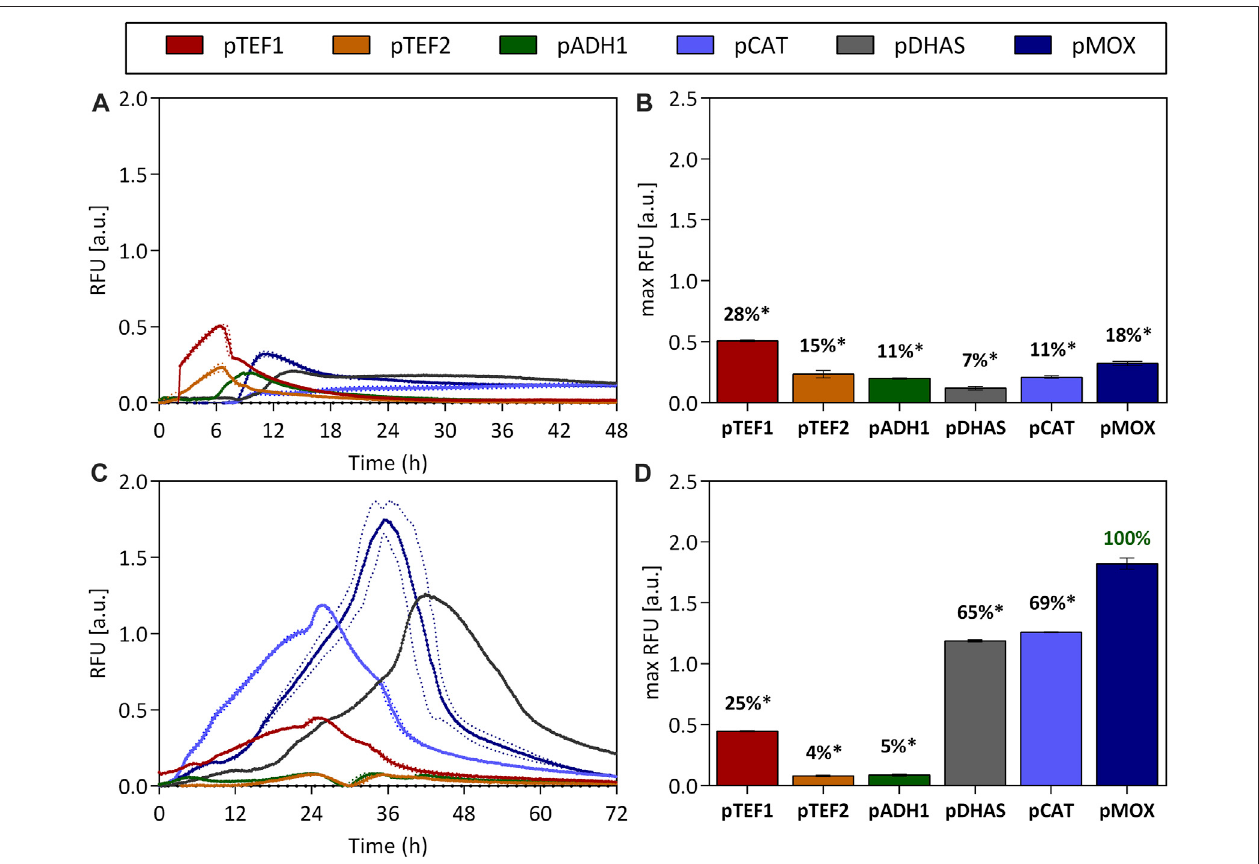
FIGURE 2 | Promoter activities on the substrate mixes glucose-methanol (A,B) and glycerol-methanol (C,D) . The constitutive promoters pTEF1 and pTEF2, pADH1 and promoters implicated in methanol metabolism such as pMOX, pDHAS and pCAT were tested over the time-course of a batch cultivation (A,C) on the two substrate mixes. The GFP ’ s fl uorescence normalized by the biomass density (expressed as RFU) was measured in a 48-well plate format. Additionally, maximum RFU values were extracted and percentages were calculated in relation to the strongest promoter pMOX on glycerol-methanol (100%). Statistical signi fi cance (indicated with *when p < 0.05) was tested with an unpaired t -test between the max RFU of the various promoters and the highest max RFU of the dataset [pMOX 100% in green in (D) ] see Supplementary Table S6 . Dotted lines (A,C) and error bars (B,D) represent the standard deviation from three biological